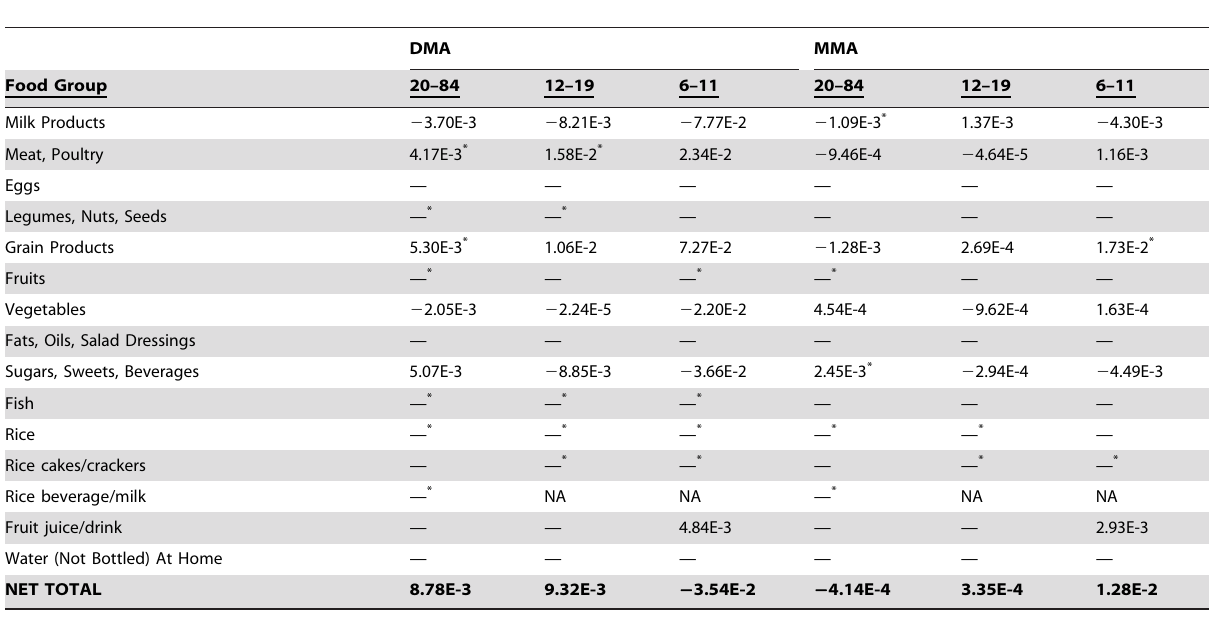
Table 6. Sample-weighted change in urinary methylated arsenic species [nmol/L per kg body weight] attributable to consuming each food group at the median amount estimated from NHANES 2003–2010 data.